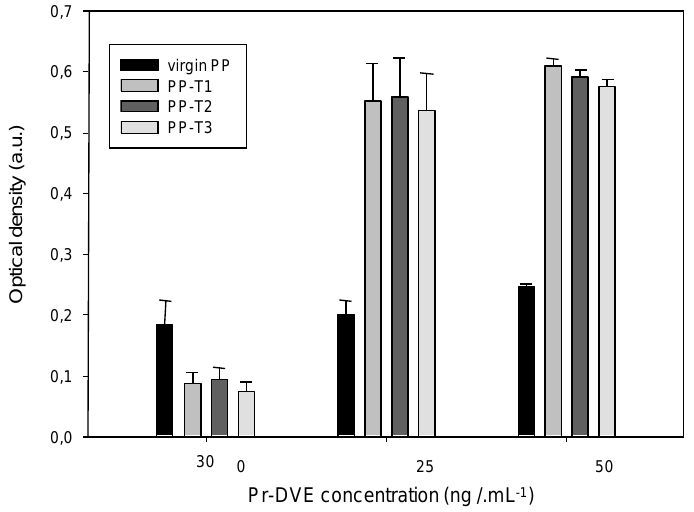
Figure 5. Dependence of the (D – D0)/D0 ratio on the well inner-surface nature and